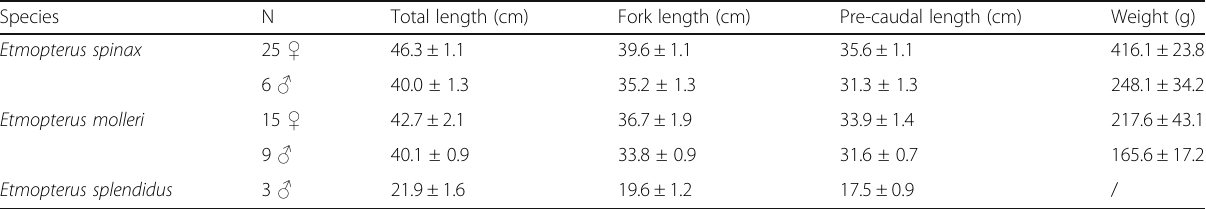
Table 1 Mean morphological values. N: number of specimens; ♀ : female; ♂ : male Species N Total length (cm) Fork length (cm) Pre-caudal length